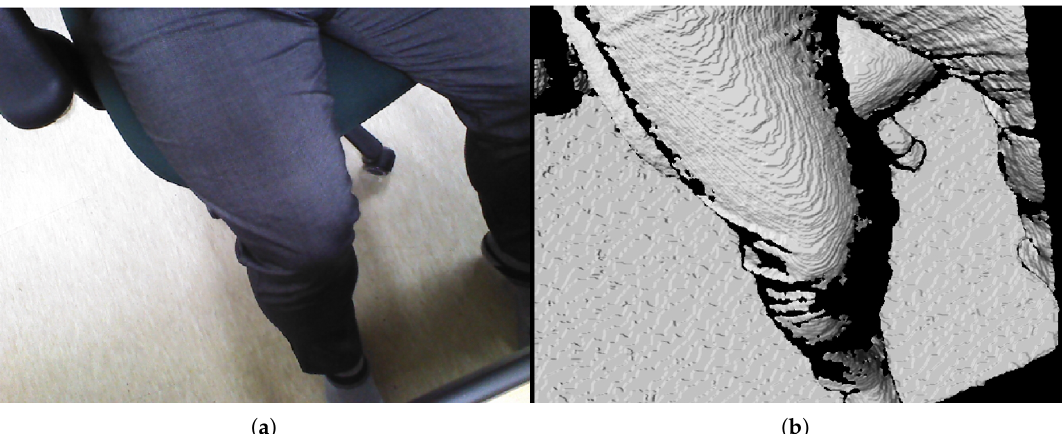
Figure 6. Point cloud example by RGB-D camera [41]. ( a ) Point cloud example (RGB data). ( b ) Point cloud example (D data).